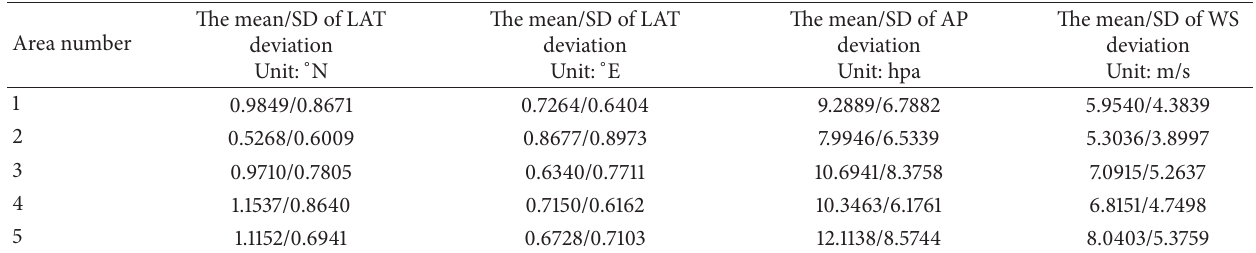
Table 7: Prediction results in landing prediction pattern.